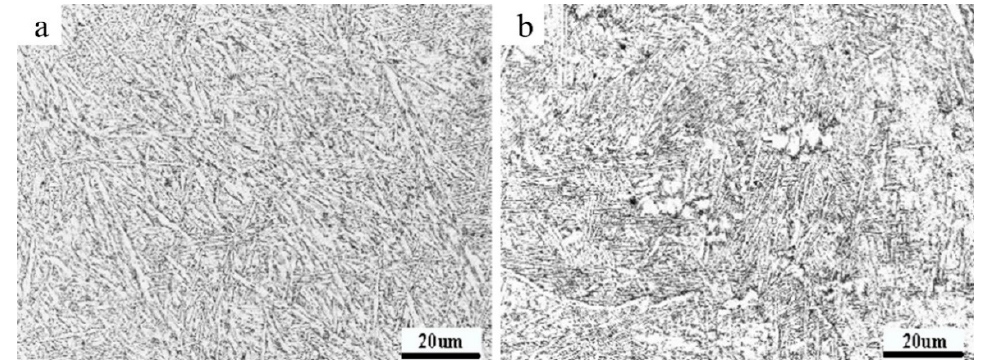
Figure 10. Effect of line offset on the microstructure morphology of Ti-6Al-4V alloy: ( a ) 0.16 mm; ( b ) 0.28 mm.